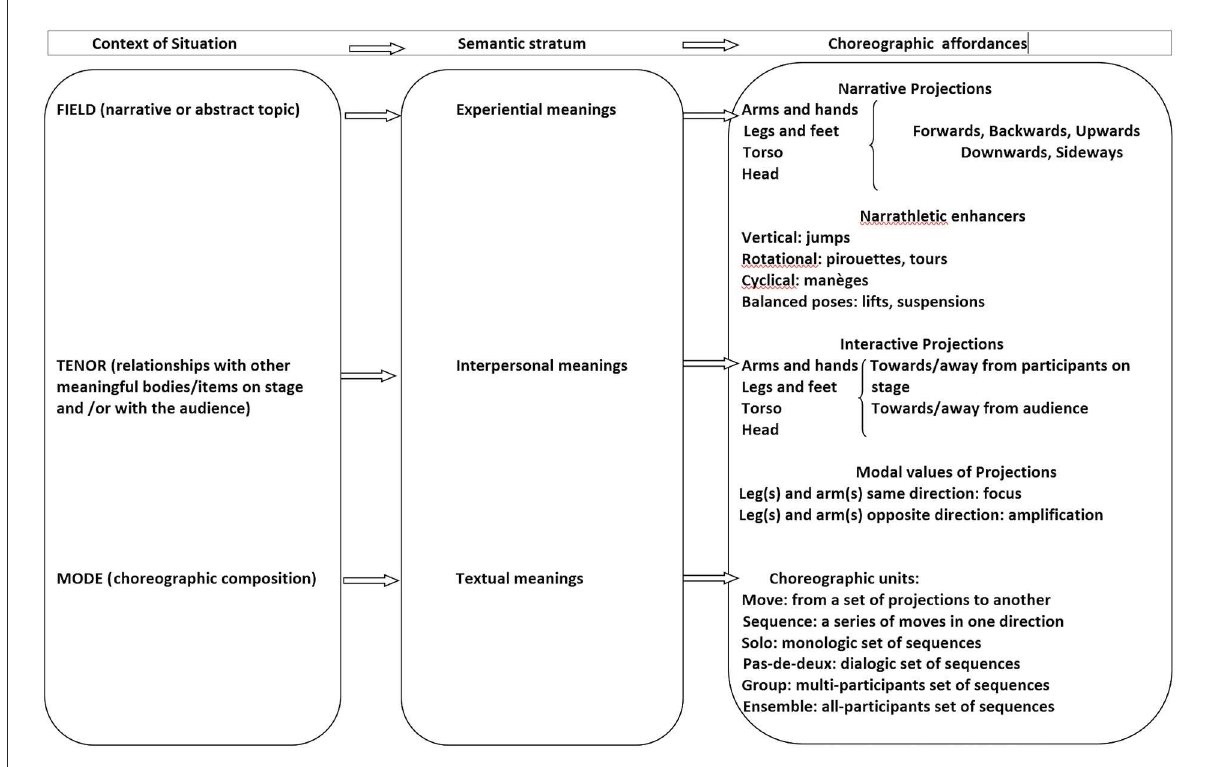
FIGURE2 The Functional Grammar of Dance movement model (Maiorani, 2021a, p.